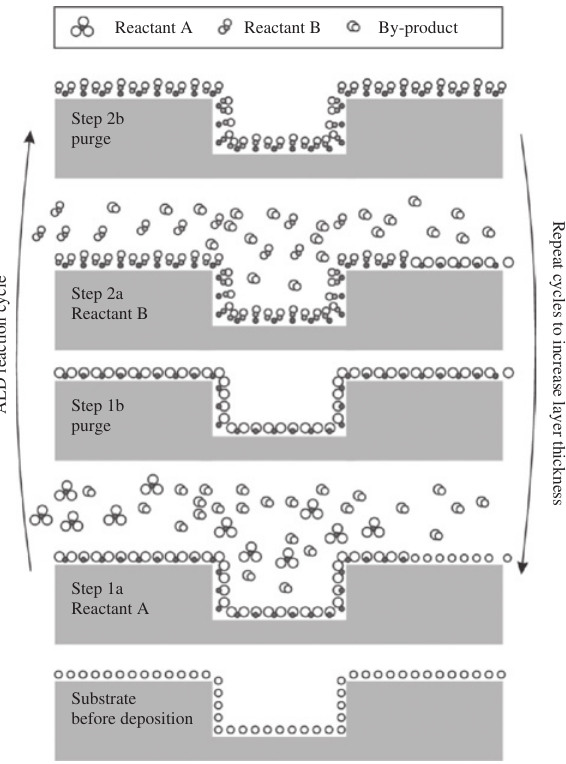
Figure 2: Schematic illustration of one ALD cycle. Reprinted with permission from Ref. [7]. Copyright 2013 AIP Publishing.